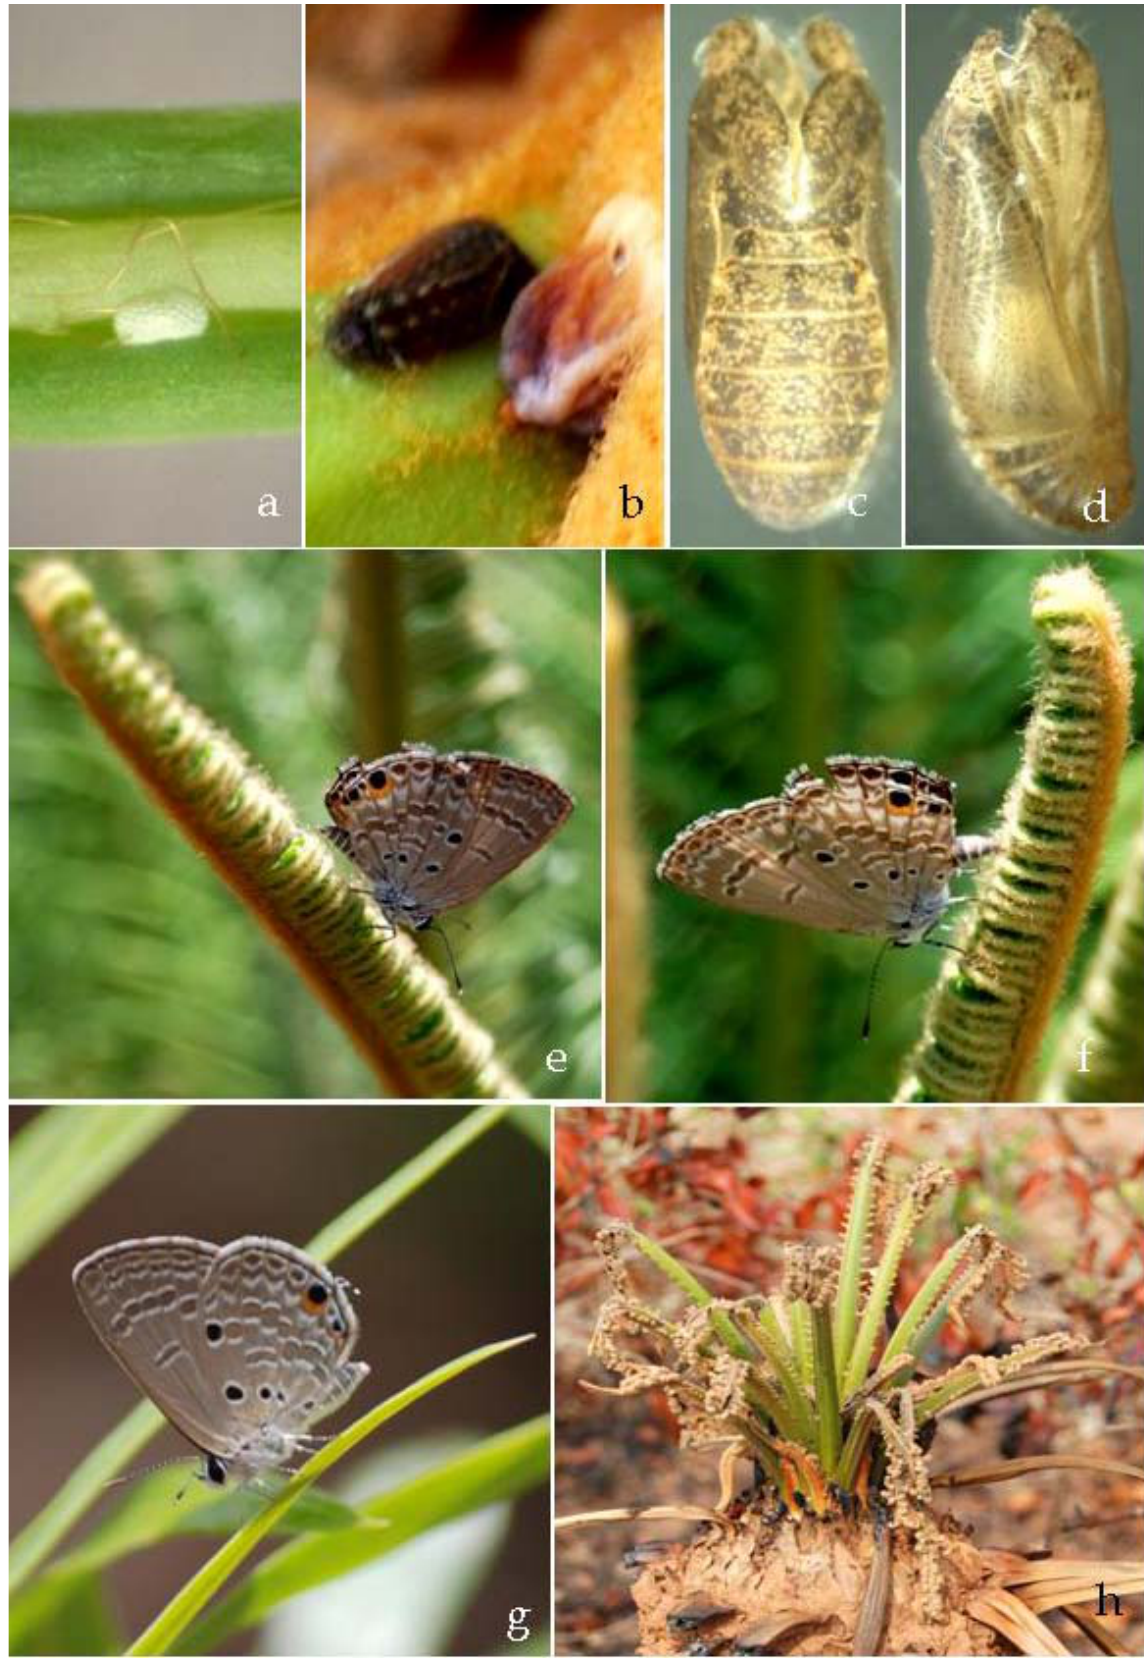
Image 3. Chilades pandava . a-f - on Cycas beddomei. a - single egg deposition on the young leaf; b - larva; c & d - pupa; e & f - adult ovipositing on coiled leaflets. g-h - on Cycas sphaerica . g - adult about to oviposit on young leaf of seedling; h - state of coiled leaves after feeding by butterfly